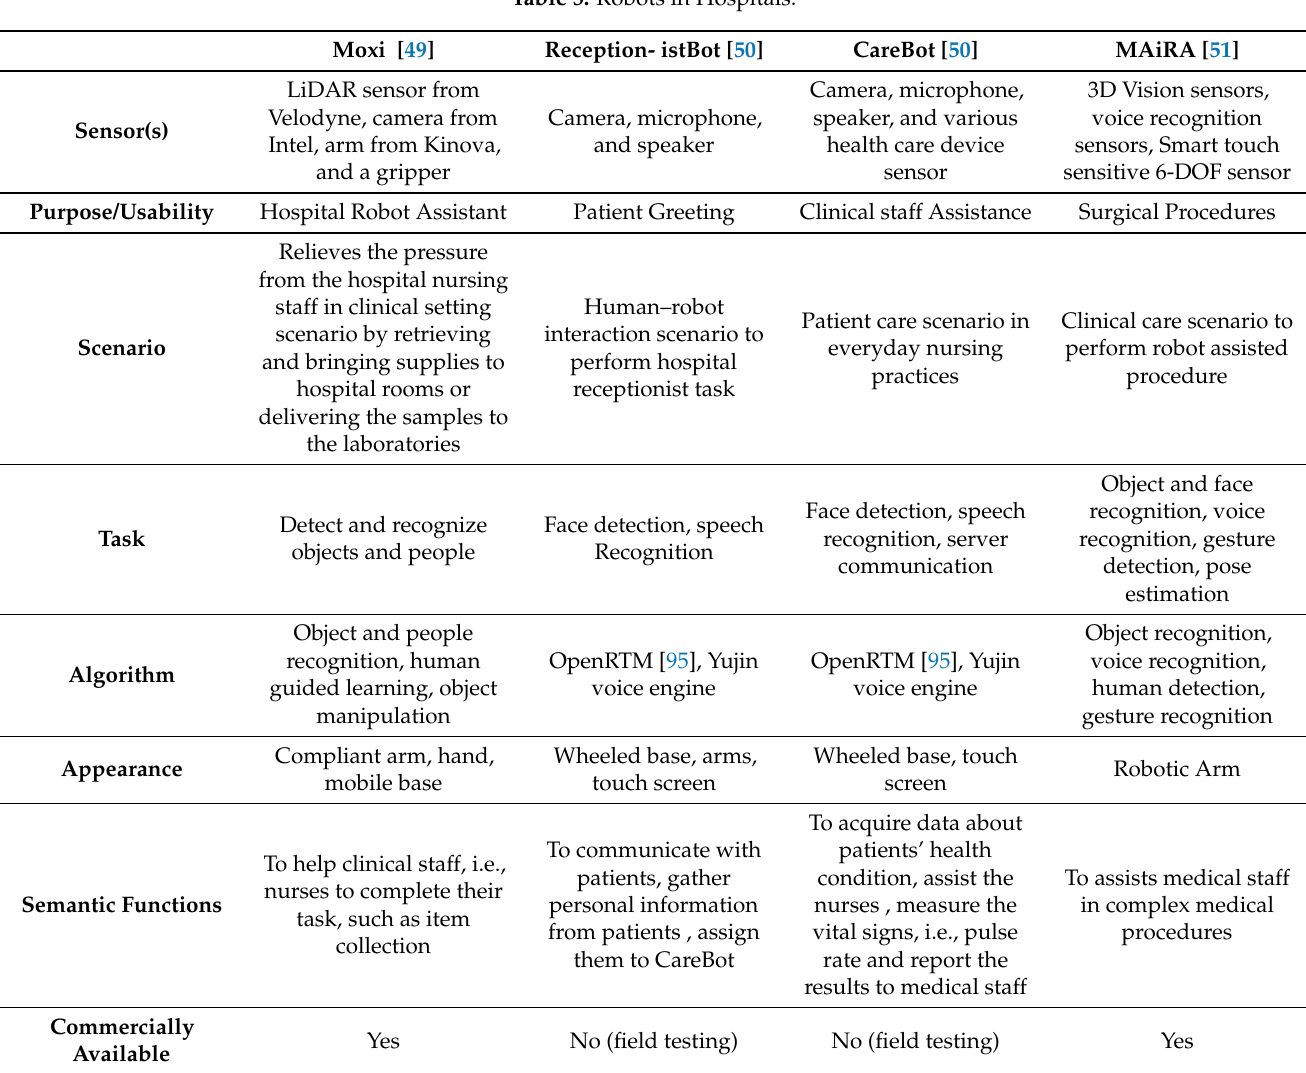
Table 5. Robots in